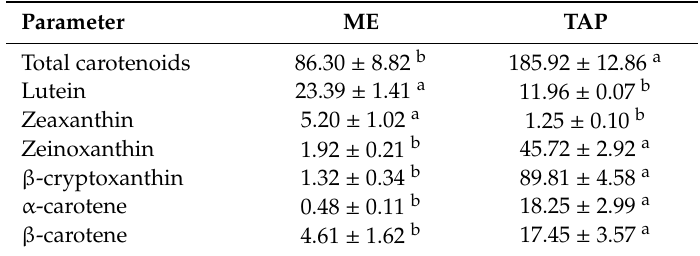
Table 2. Carotenoid content of pulp extracts of murici and tapereba ( µ g /